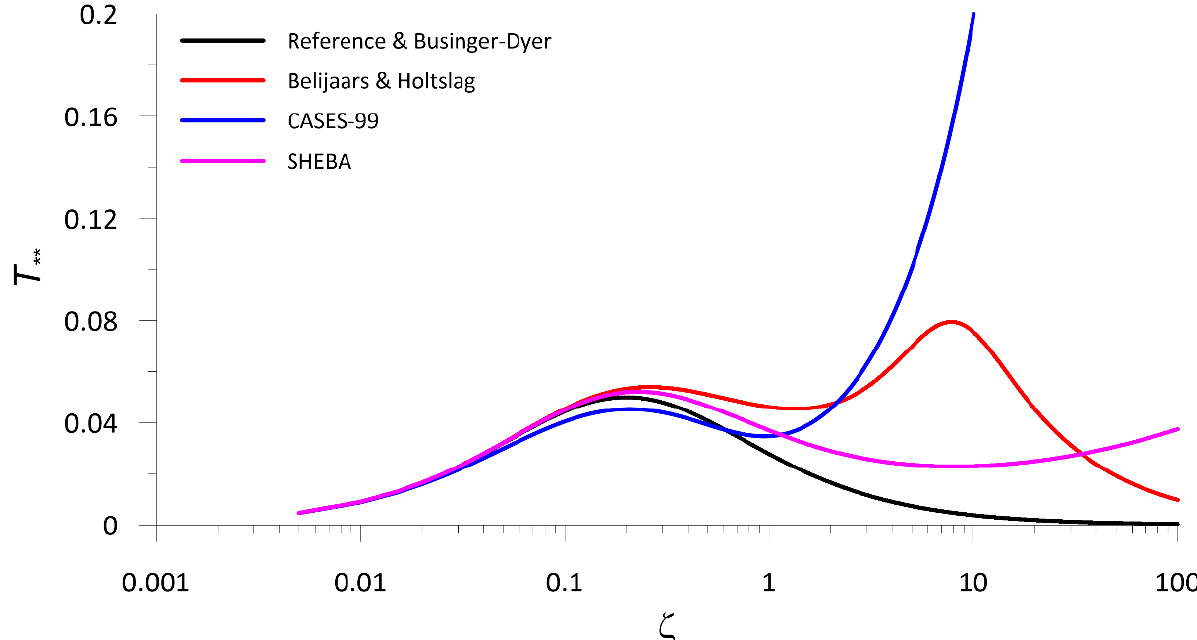
Figure 2. Evolution of T ∗∗ as a function of the stability parameter ζ for the four Φ m listed in Section 3. By inverting Equation (2b) is it possible to express H as a function of Φ h ( ζ )